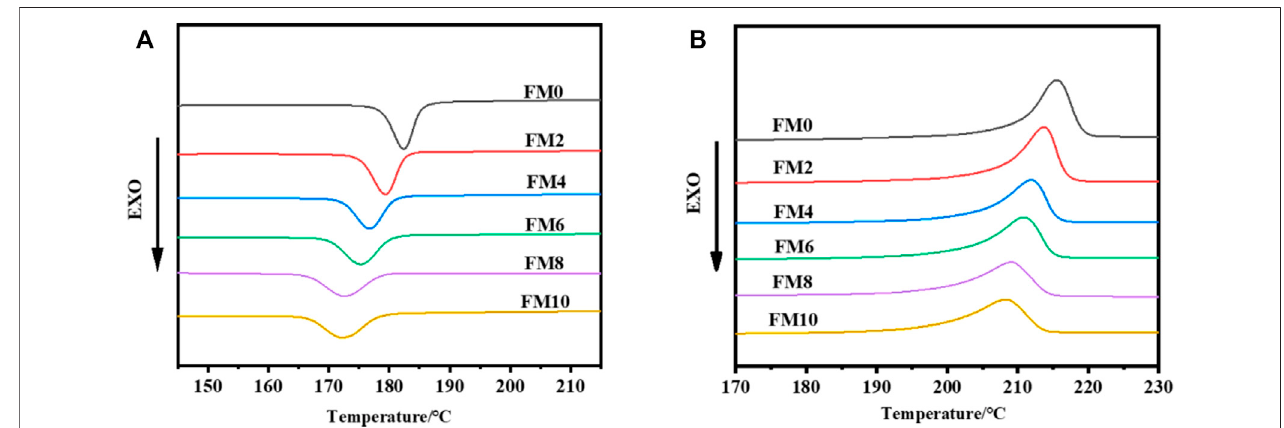
FIGURE 4 | Melting and non-isothermal crystallization curves of neat PCTFE and its blending samples with different FCO contents: (A) Cooling curves with the cooling rate of 10 ° C/min; (B) second heating curves with the heating rate of 10 ° C/min.